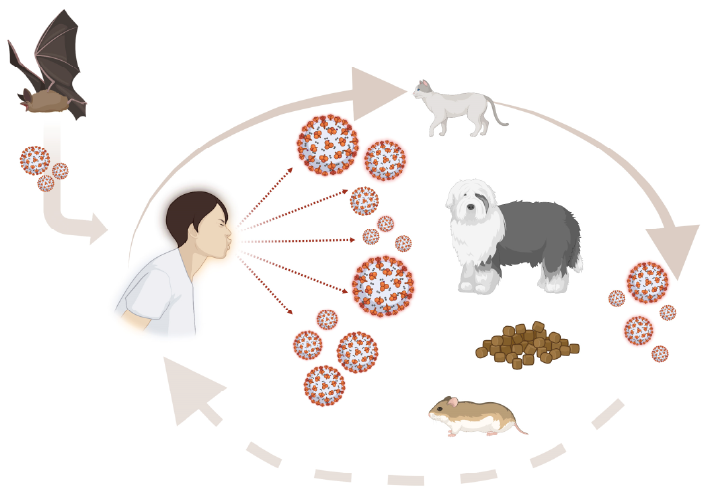
Figure 2. Possible mode of transmission of SARS-CoV-2 in humans and animals: Animal species closest to humans have always represented a potential vector for the transmission of numerous zoonotic agents. However, it is still not clear whether they could be a worrying source of infection for humans. This figure has been created using BioRender.com.